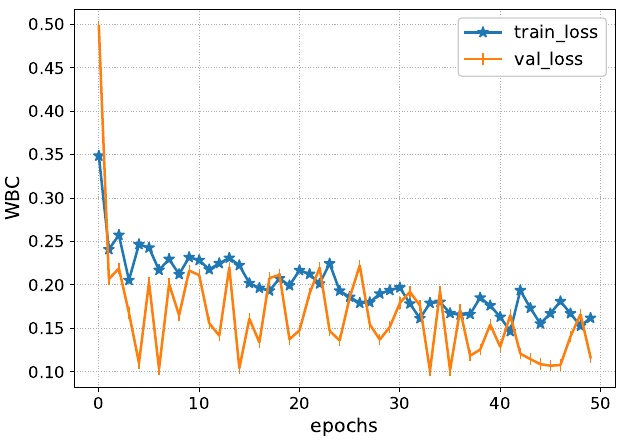
Figure 9. Loss analysis of ResNet101-V2 during